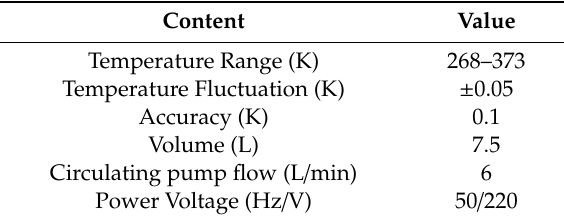
Table 6. The main technical parameters of the constant temperature bath.